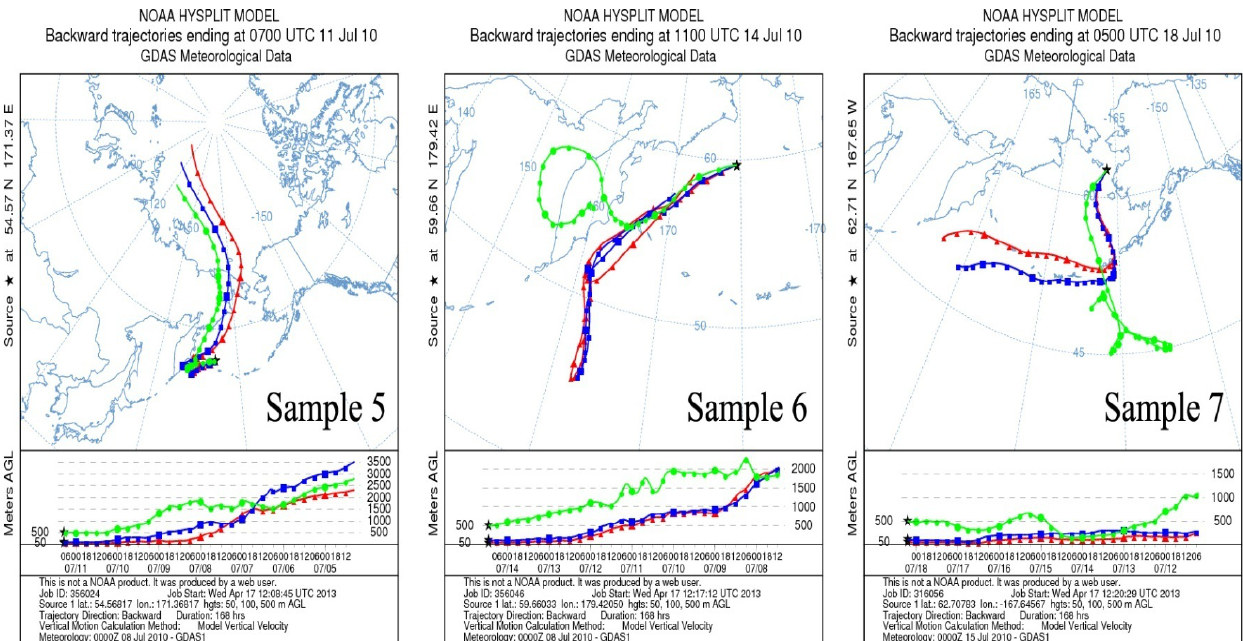
Figure 4. Backward trajectories indicating the origin of air masses for selected samples.